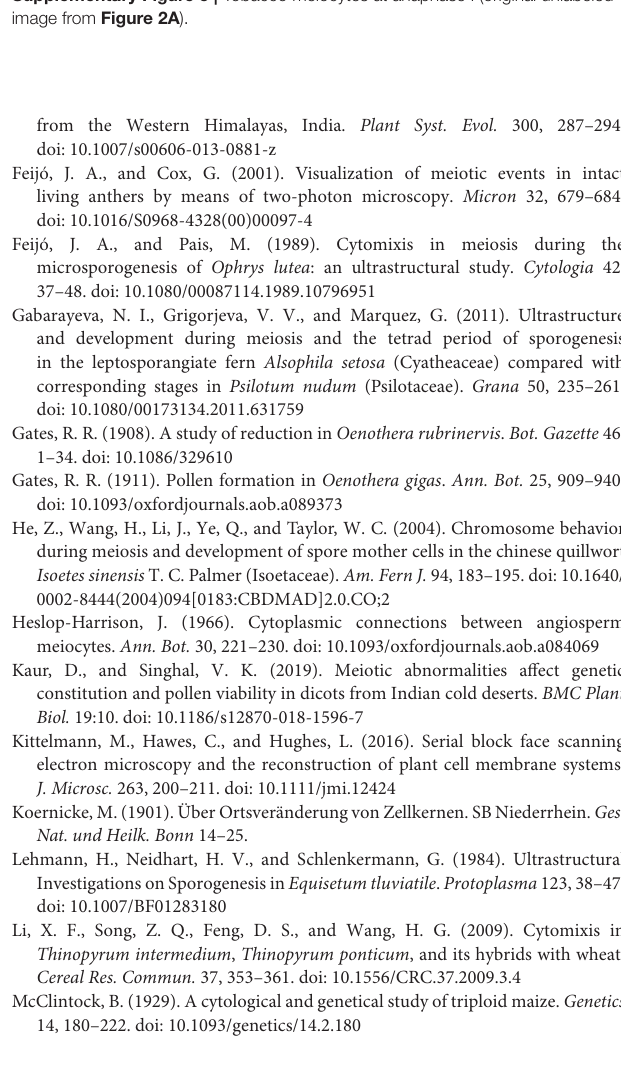
Supplementary Video 5 | An enlarged cell wall fragment. Reconstructed from 130 serial images. Orange represents CCs, green plasmodesmata, and gray the cell wall. Supplementary Figure 1 | Tobacco meiocytes at leptotene (original unlabeled image from Figure 2A ). Supplementary Figure 2 | Tobacco meiocytes at zygotene (original unlabeled image from Figure 2A ). Supplementary Figure 3 | Tobacco meiocytes at pachytene (original unlabeled image from Figure 2A ). Supplementary Figure 4 | Tobacco meiocytes at diplotene (original unlabeled image from Figure 2A ). Supplementary Figure 5 | Tobacco meiocytes at anaphase I (original unlabeled image from Figure 2A